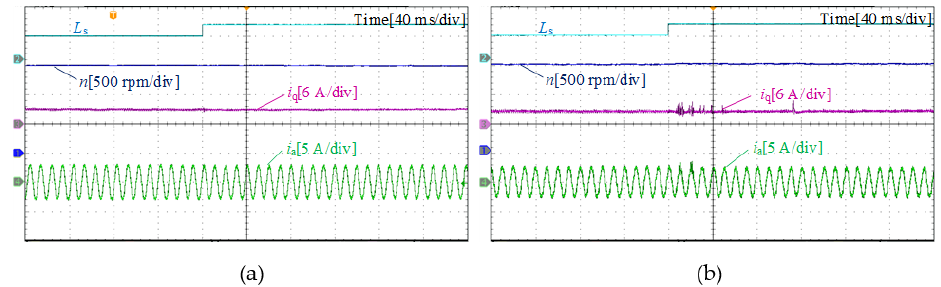
Figure 11. Experimental comparison with a +50% L s mismatch. ( a ) Proposed MPDSC. ( b ) Double- vector PDSC.